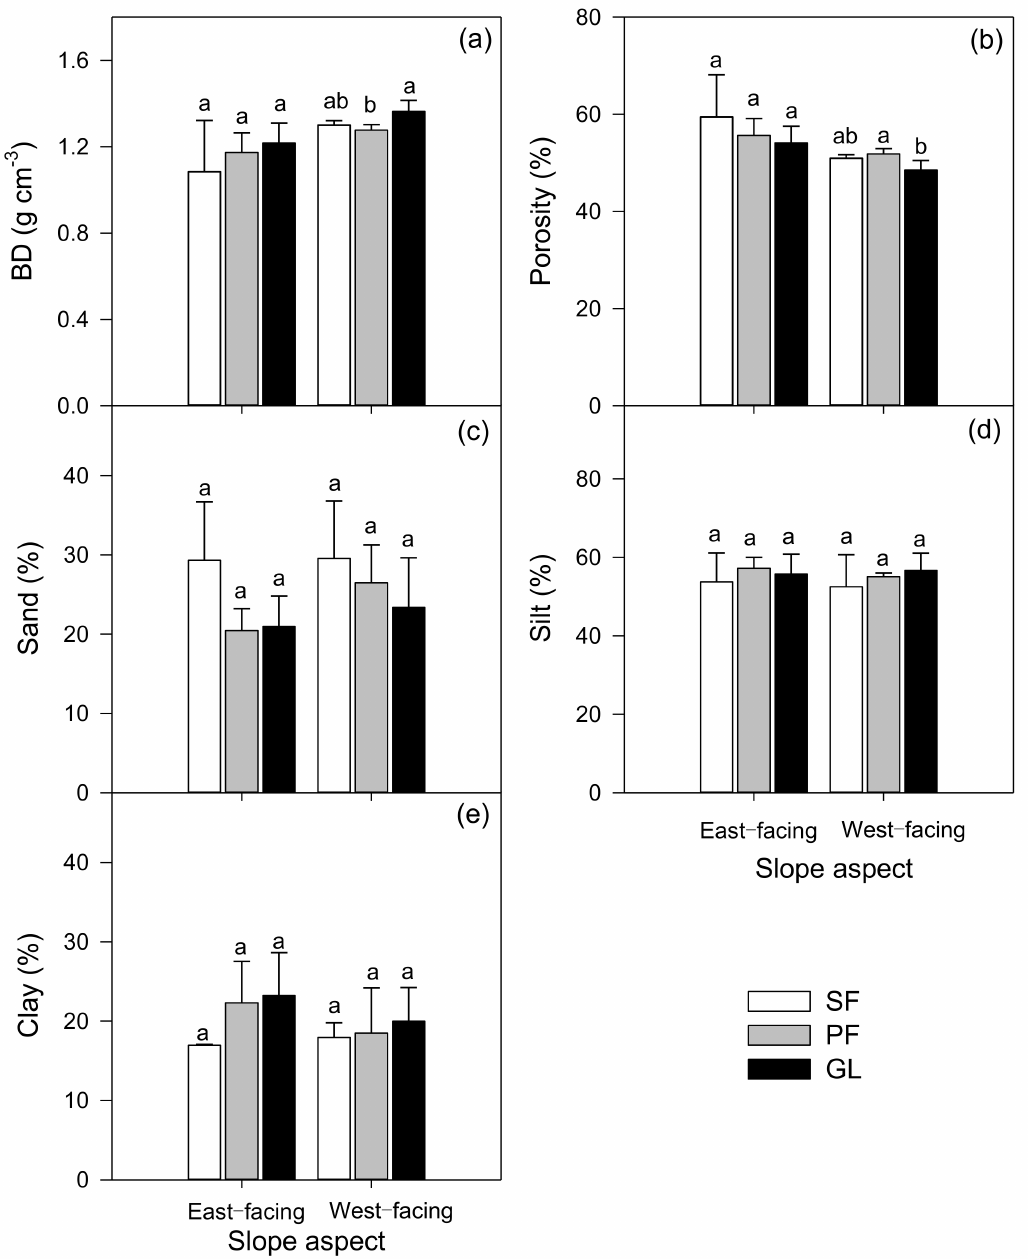
Figure 5. Soil BD ( a ), porosity ( b ), sand ( c ), silt ( d ), and clay ( e ) percentages at 0 − 20 cm soil depth in different land uses on east − facing and west − facing slopes, respectively. Error bars represent standard deviation of means. Different lowercase letters denote significant differences among land uses in a specified slope aspect. SF, secondary forest; PF, plantation forest; GL,